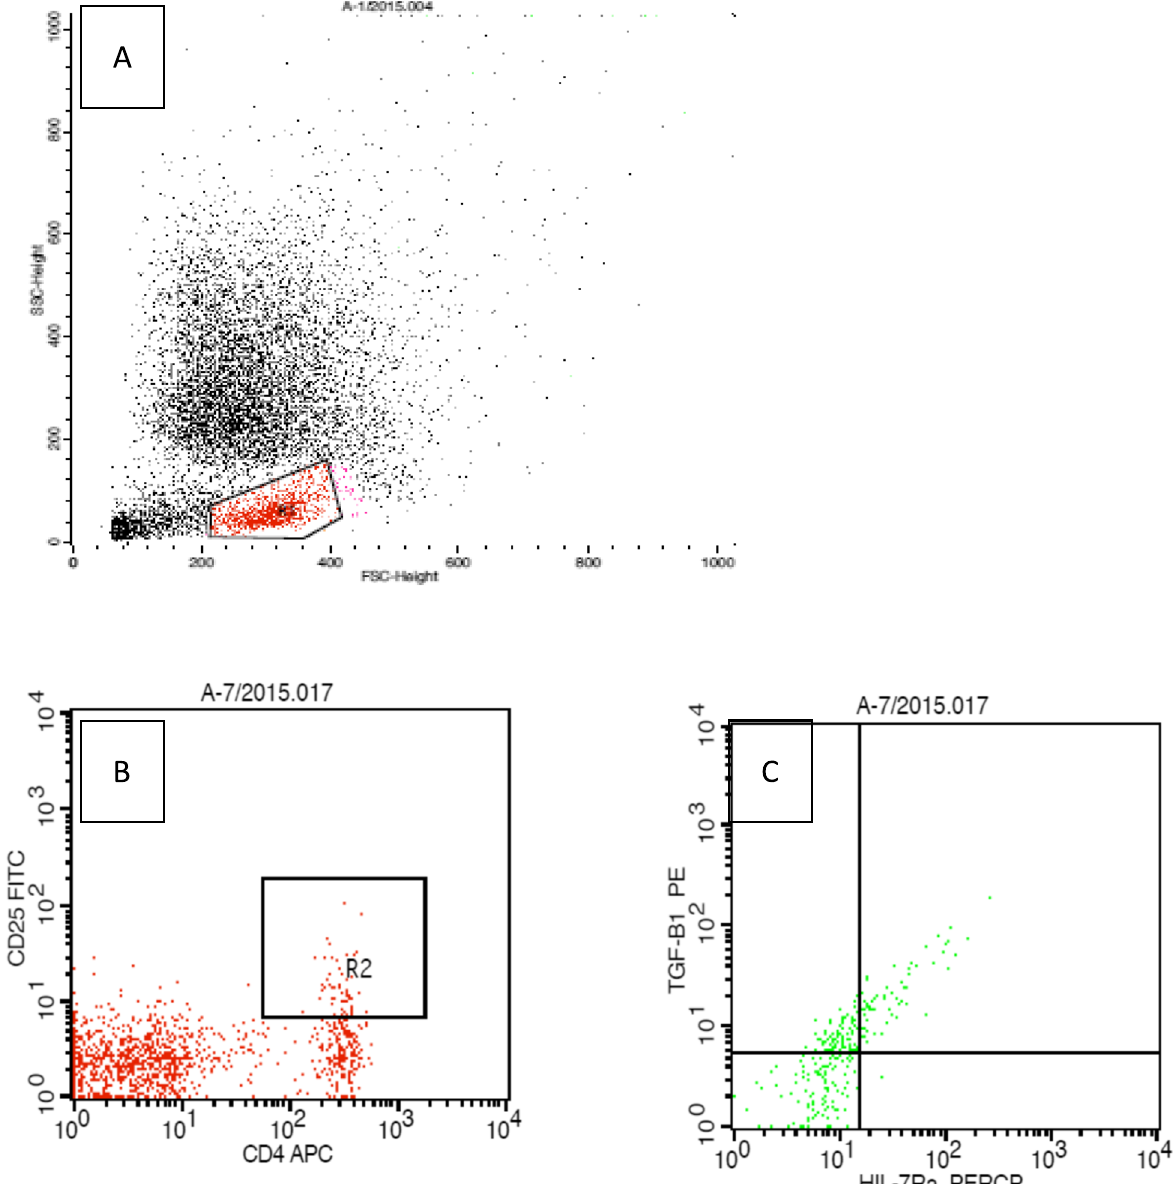
Fig. 1 A Forward (FSC) and side (SSC) scatter histogram was used to define lymphocyte population in peripheral blood mononuclear cell. B The CD4 CD25 cells (R2) was assessed within the lymphocyte population (R1) by their co expression of CD4 + + The expression of mTGF‑ß1 was assessed on Tregs CD4 CD25 Tregs in upper left + +